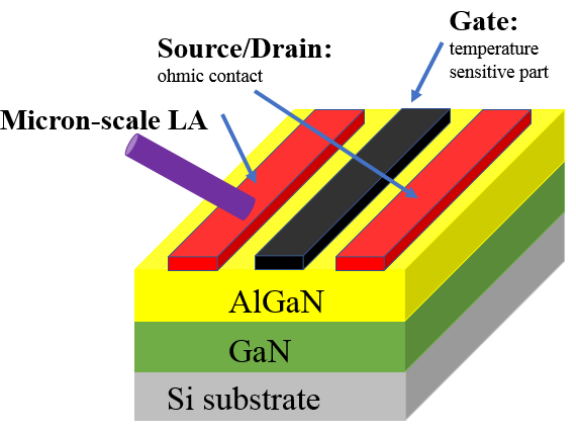
Figure 16. The schematic diagrams of micron-scale LA.